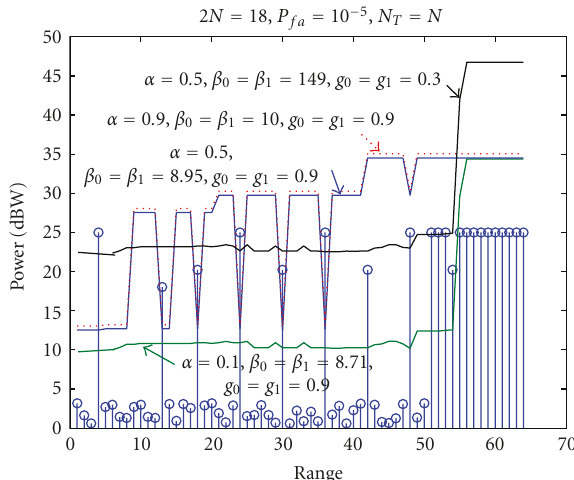
Figure 14: Detection thresholds of SOS I with di ff erent parameters in worst case for 2 N = 18 and P fa = 10 − 5